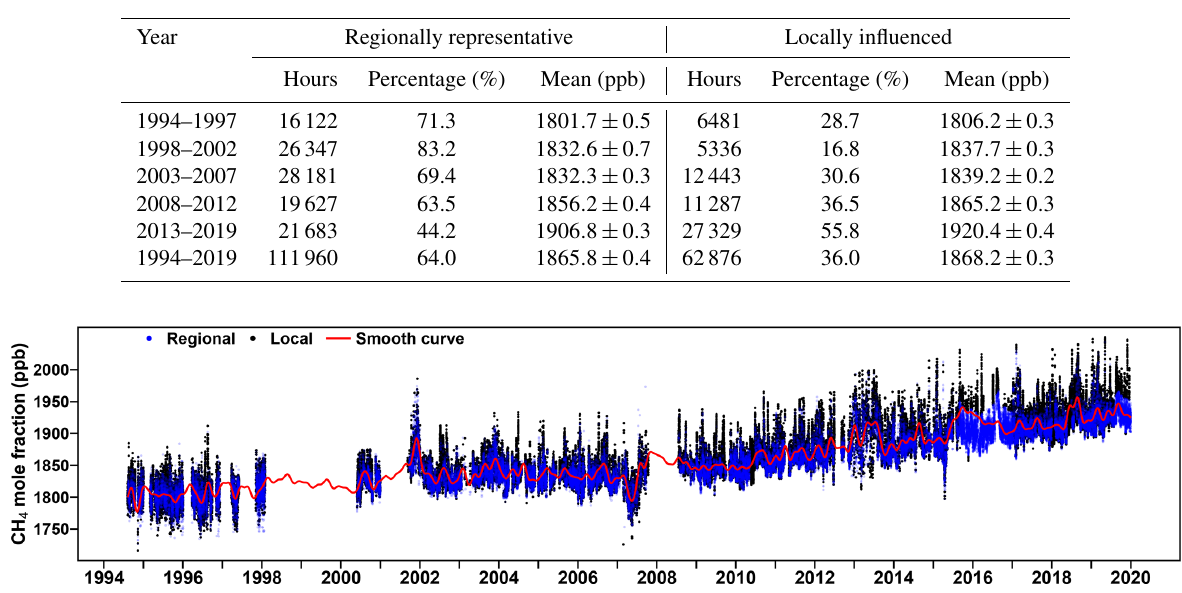
Figure 2. The filtered hourly CH 4 data series, from 1994 to 2019, at the WLG station. The transparent blue points are regionally representative data. The black points are locally influenced data. The red lines are the smooth values of the regional data obtained by the curve-fitting routine of Thoning et al. (1989).